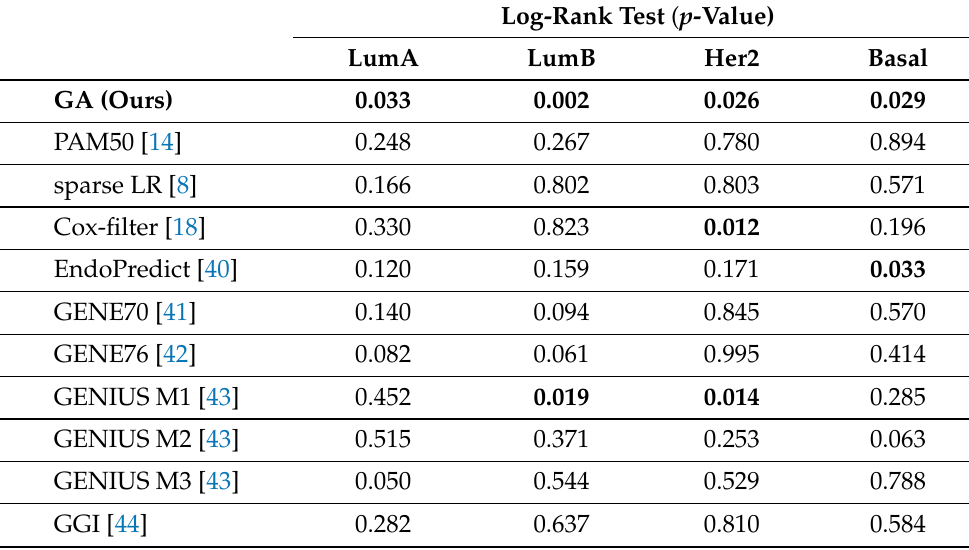
Table 3. Performance comparison on SCAN-B data set. For prognosis stratification, the p -value of the log-rank test result within each subtype is shown, and significant results are marked in bold ( p -value < 0.05). The results of the TCGA-BRCA data set are shown in Table S3.